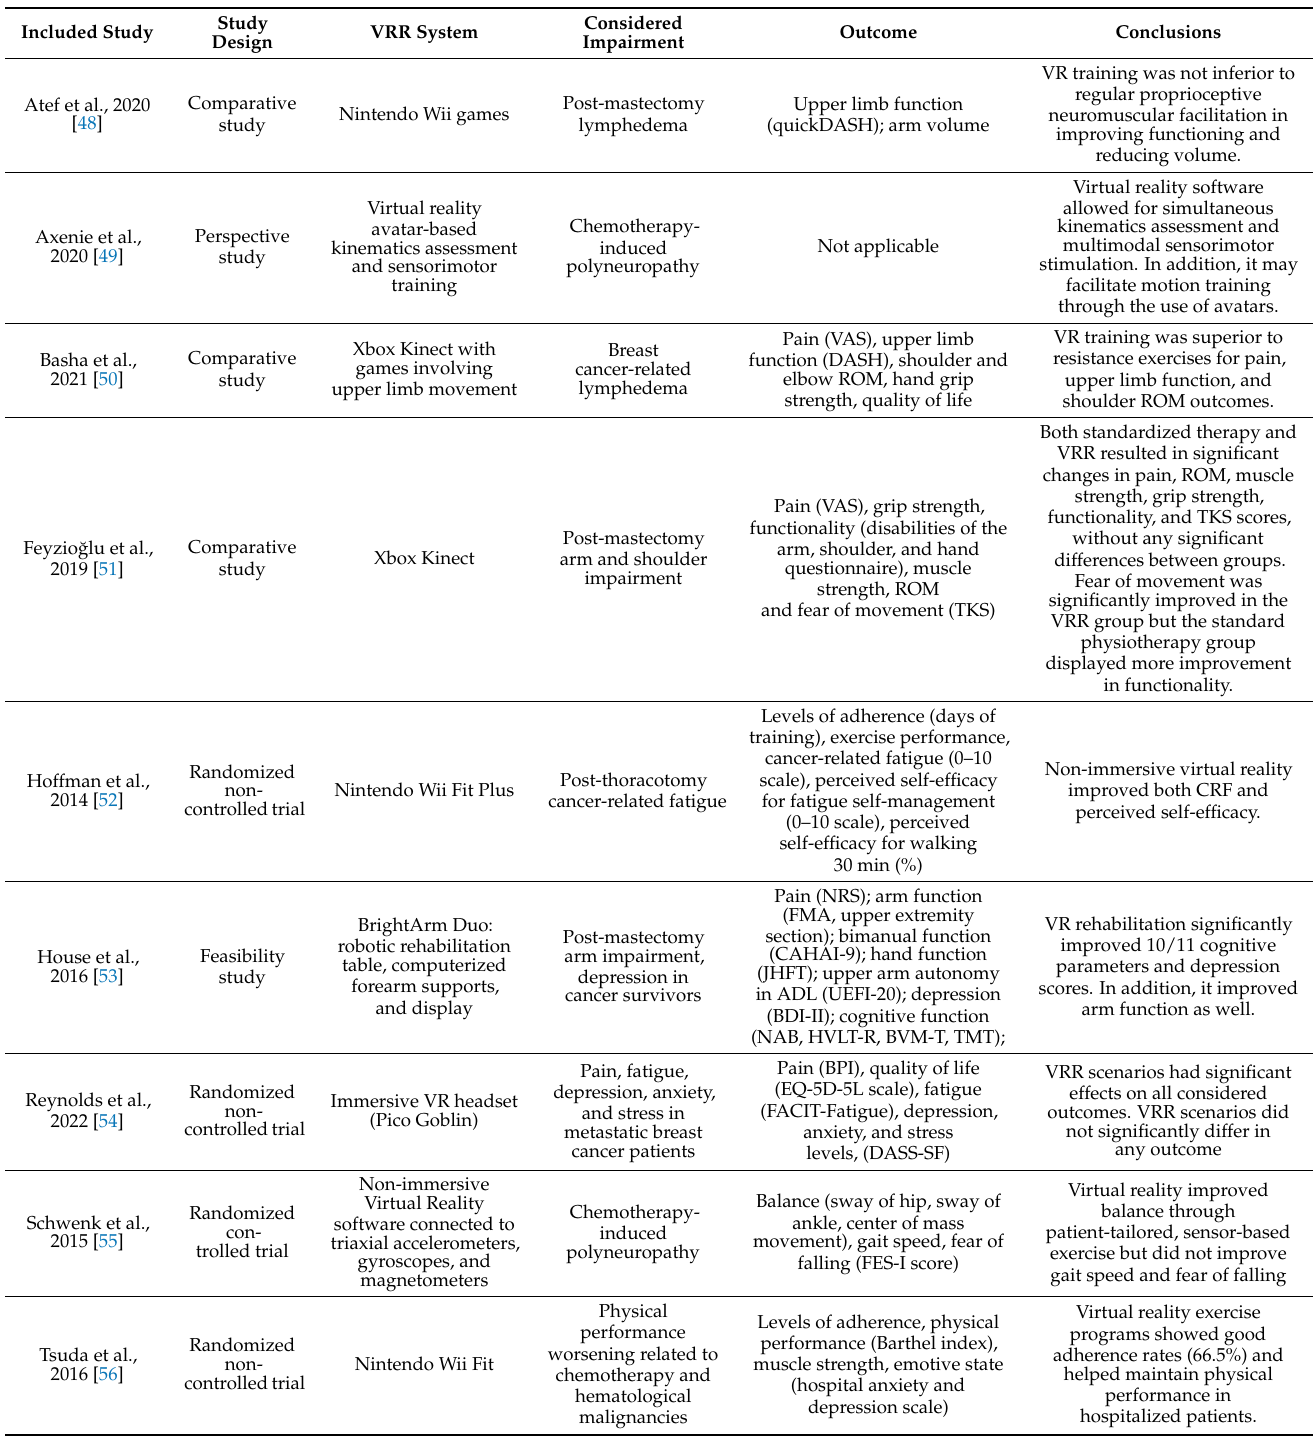
* Table 1: Features of the included studies. VR: Virtual reality; VAS: visual analogue scale; DASH: disability of the arm, hand, and shoulder questionnaire; ROM: range of motion; TKS: Tampa Kinesiophobia Scale; CRF: cancer-related fatigue; NRS: numeric rating scale; FMA: Fulg-Meyer assessment; CAHAI-9: Chedokee arm and hand activity inventory; JHFT: Jebsen hand function test; ADL: activities of daily living; UEFI-20: upper extremity function index; BDI-II: Beck Depression Inventory, Second Edition; NAB: Neuropsychological Assessment Battery; HVLT-R: Hopkins Verbal Learning Test; BVMT-R: the Brief Visuospatial Memory Test, Revised; TMT: Trail